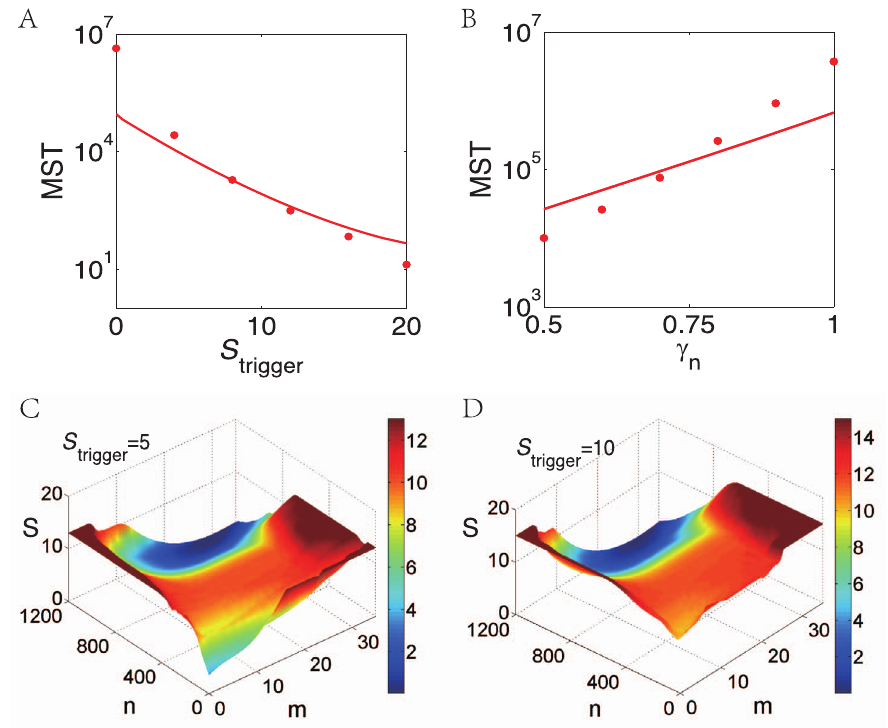
Figure 5. The mean switching time (MST) of off-to-on transition as a function of (A) trigger signal strength that transcribes mRNA at constant rate and (B) degradation rate of protein c n . (C) and (D): Quasipotential energy landscape with different trigger strength. S trigger ~ 5 in (C), and S trigger ~ 10 in (D). Other parameters are a 0 ~ 0 : 4, a ~ 400, b ~ 40, c 1 ~ 1, k 1 ~ 0 : 0002, c m ~ 10 ; c n ~ 1 in (A,C,D), and S trigger ~ 0 in (B).